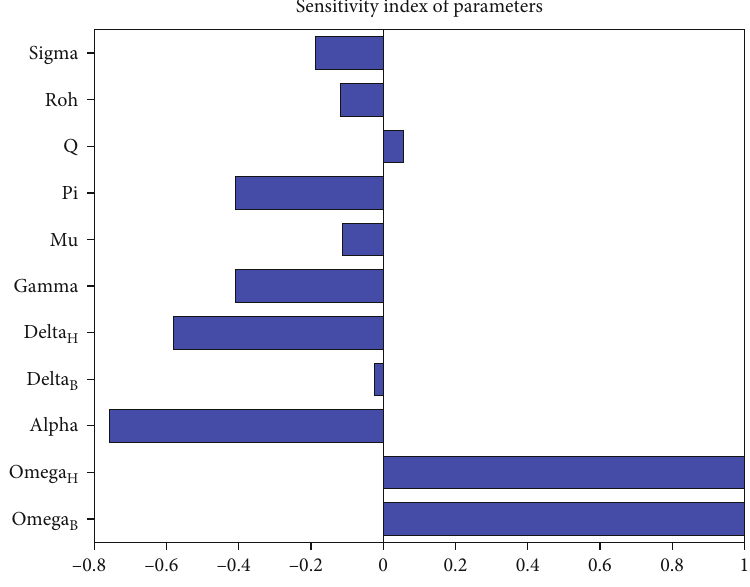
Figure 2: Sensitivity index of parameters. Table 2: Parameter values used in numerical